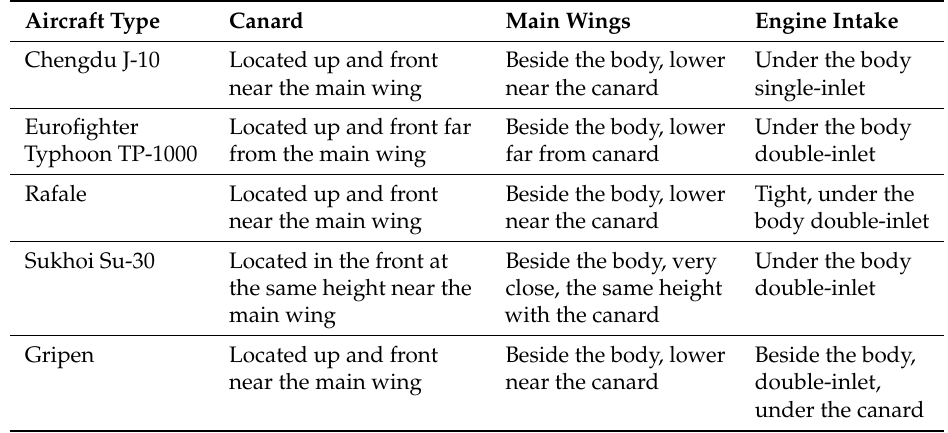
Table 1. Structural configuration comparison between canard, main wing and engine intake for different popular canard fighters.